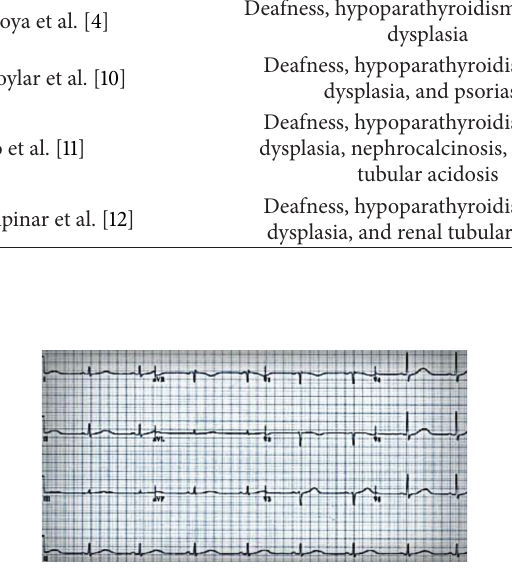
Figure 1: Electrocardiography showed a prolonged QT interval